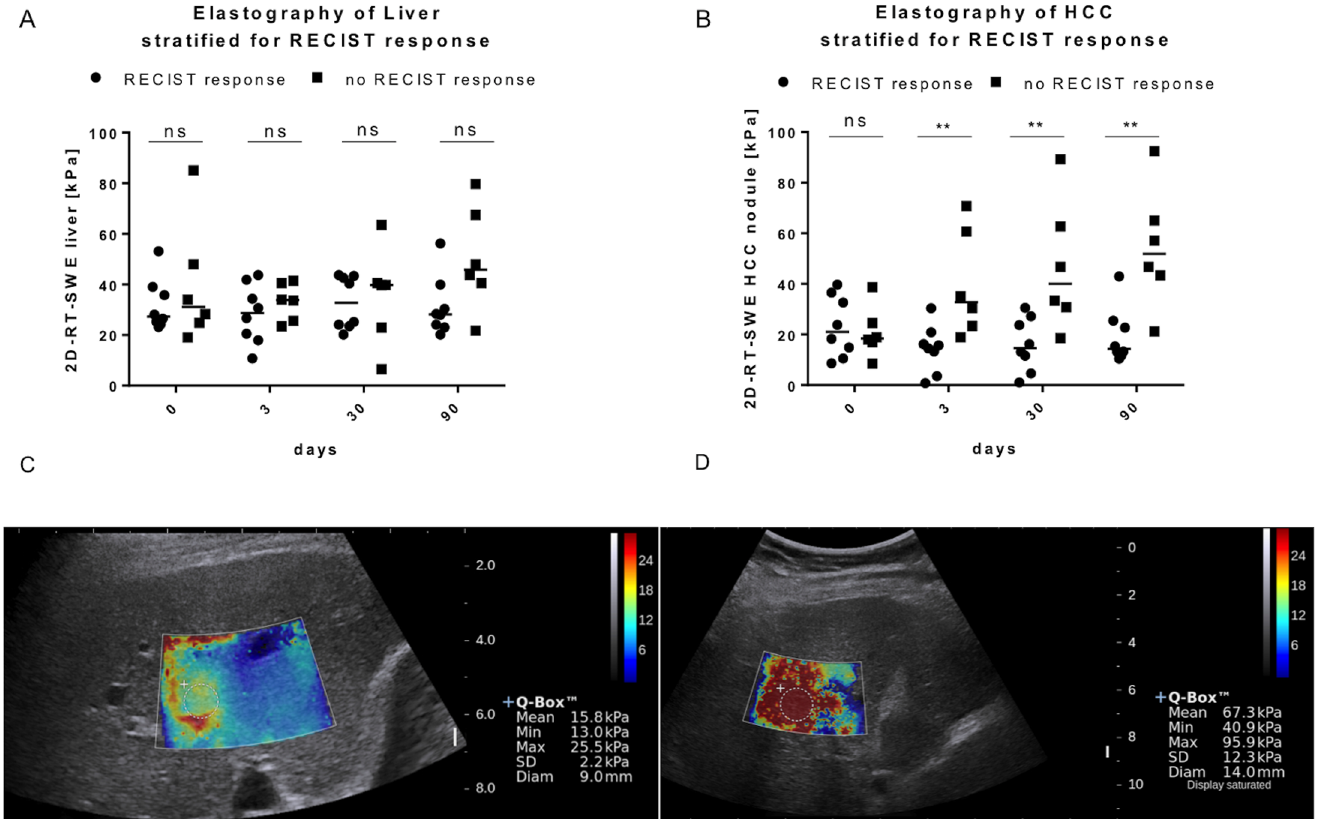
Fig 4. Dynamics of HCC and liver stiffness and examples. A) Dynamic in changes in median stiffness of the liver at different time points before and after local ablative therapy stratified for local response. B) Dynamic in changes in median stiffness of the liver at different time points before and after local ablative therapy stratified for occurrence of Non-TL. Example of an HCC nodule with low C) and high D) stiffness after local ablative